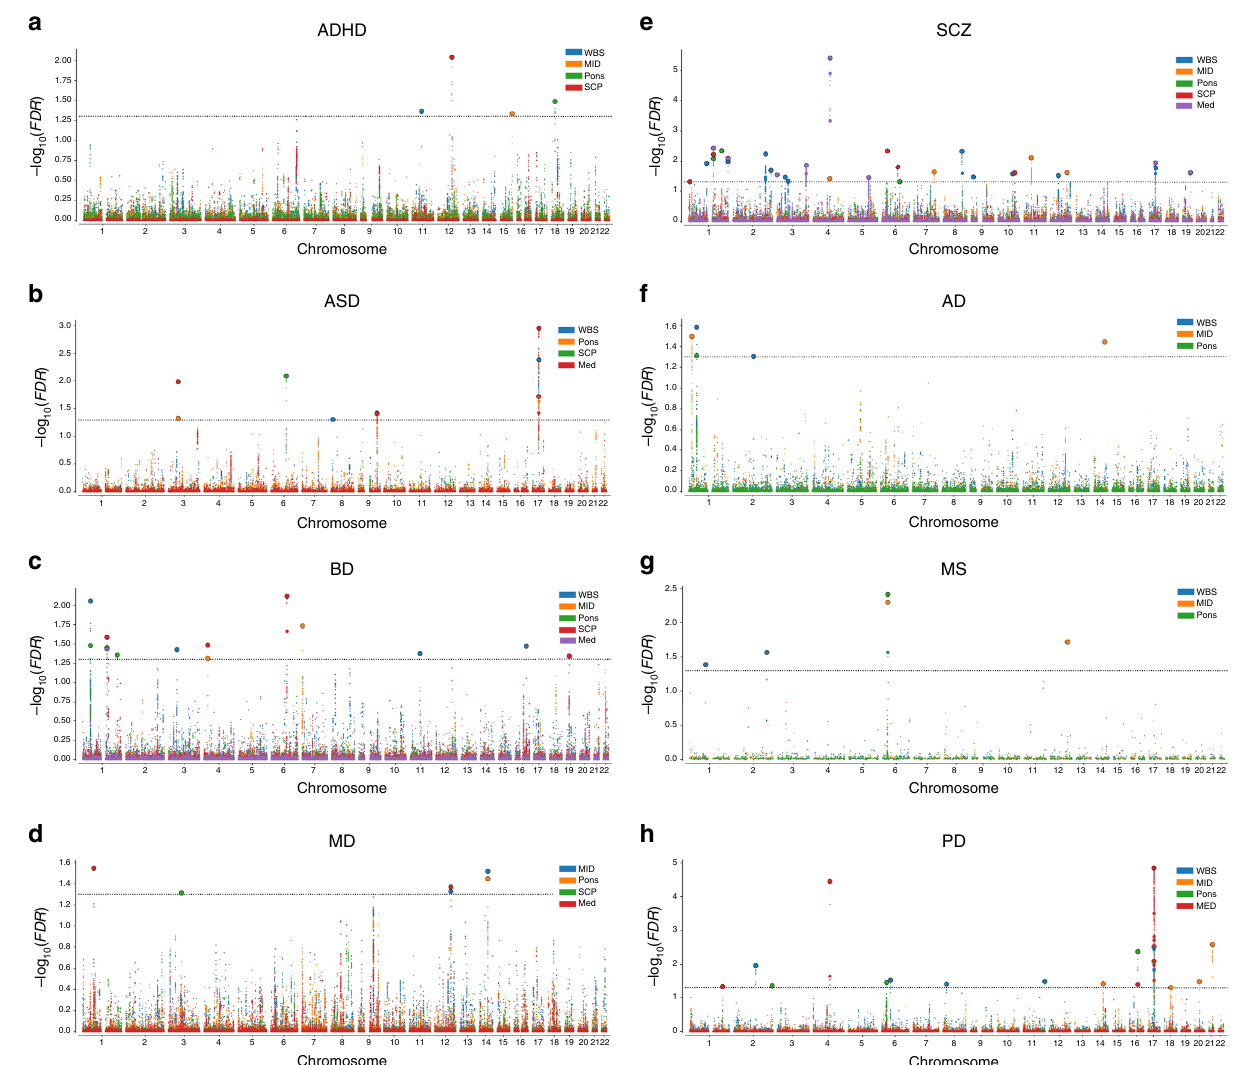
Fig. 4 Manhattan plots for genetic loci shared between brainstem volumes and eight common brain disorders. a 4 shared loci in ADHD, b 9 shared loci in ASD, c 14 shared loci in BD, d 6 shared loci in MD, e 31 shared loci in SCZ, f 5 shared loci in AD, g 5 shared loci in MS, and h 17 shared loci in PD. WBS whole brainstem. MID midbrain. SCP superior cerebellar peduncle. MED medulla oblongata. ADHD attention-de fi cit/hyperactivity disorder. ASD autism spectrum disorders. BD bipolar disorder. MD major depression. SCZ schizophrenia. AD Alzheimer ’ s disease. MS multiple sclerosis. PD Parkinson ’ s disease. The black horizontal lines indicate conjunctional false discovery rate threshold